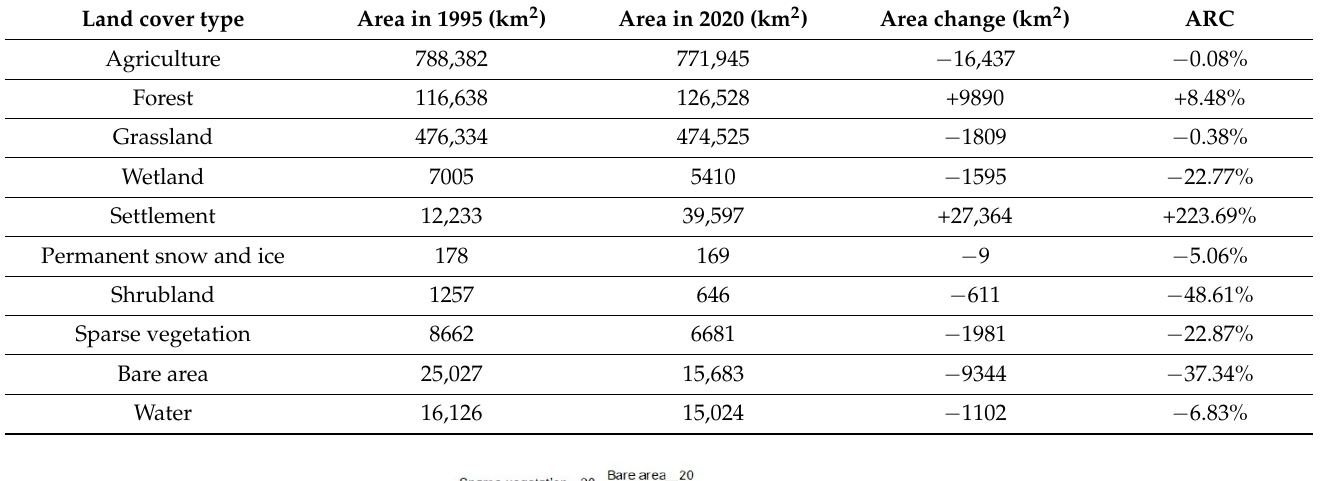
Table 3. Land cover change from 1995 to 2020.